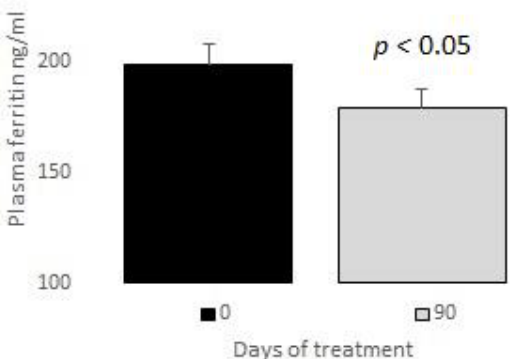
Figure 1. Plasma ferritin basal vs. 90 days of treatment with resveratrol, piperine and alpha-tocopherol in MetS patients.